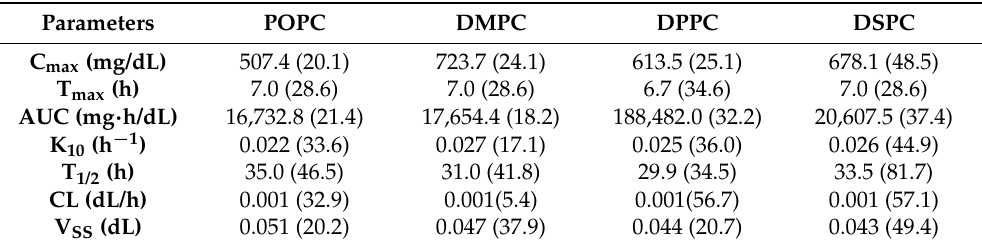
Figure 4. A pharmacokinetic/pharmacodynamic study was completed using Sprague Dawley Rats. Micelles were injected via tail vein injection and blood was collected from the jugular vein at various time points between 0 and 48 h post-injection. The concentration of ( A ) phospholipid, ( B ) total cholesterol (TC), ( C ) free cholesterol (FC), and ( D ) cholesterol ester (CE), over a 48-h time frame were measured using commercially available kits. Profiles of concentration vs. time are displayed over a 48 h time period ( n = 4, mean ± SD). Table 2. Pharmacokinetic parameters (% CV) of phospholipids after a 136 μ mol/kg dose of micelles containing different PC lipids.